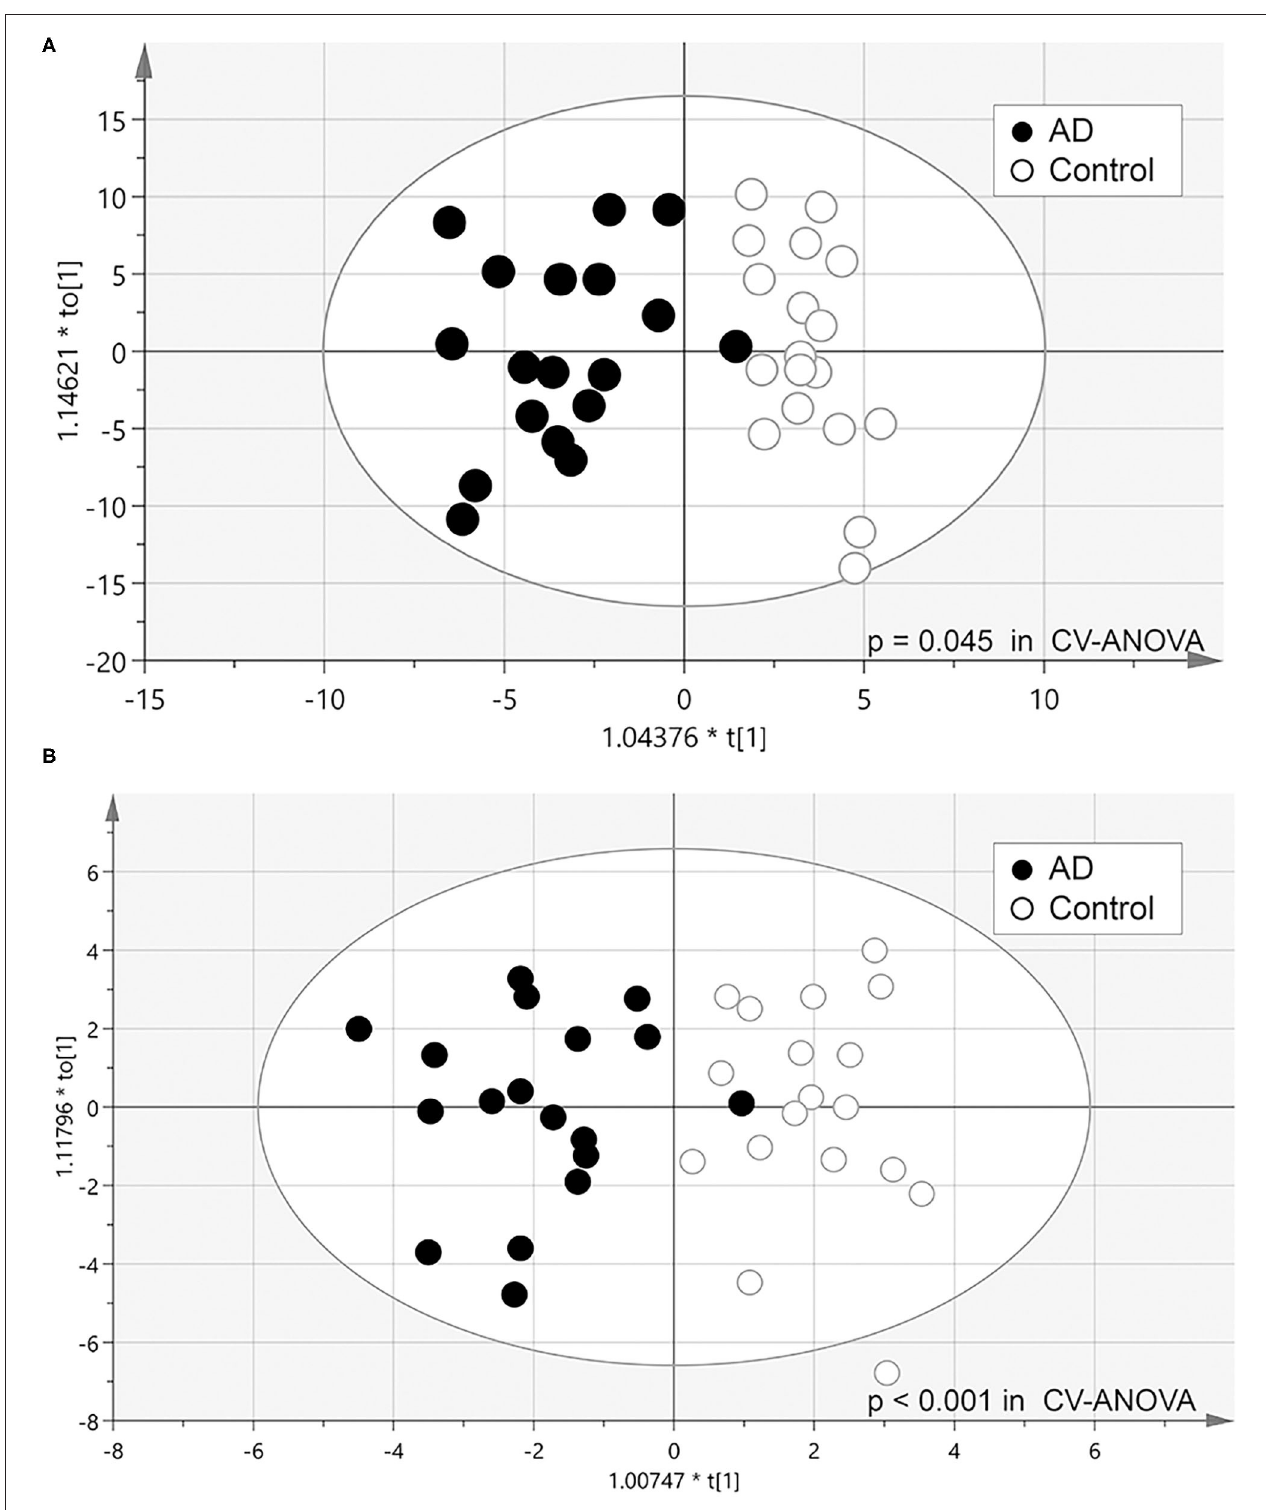
FIGURE 1 | Scatter plot of OPLS-DA analysis. (A) Model 1: model constructed from all 279 metabolites identified (Model 1). (B) Model 2: model constructed from 26 metabolites that significantly differed in Wilcoxon’s rank-sum test ( P < 0.05).